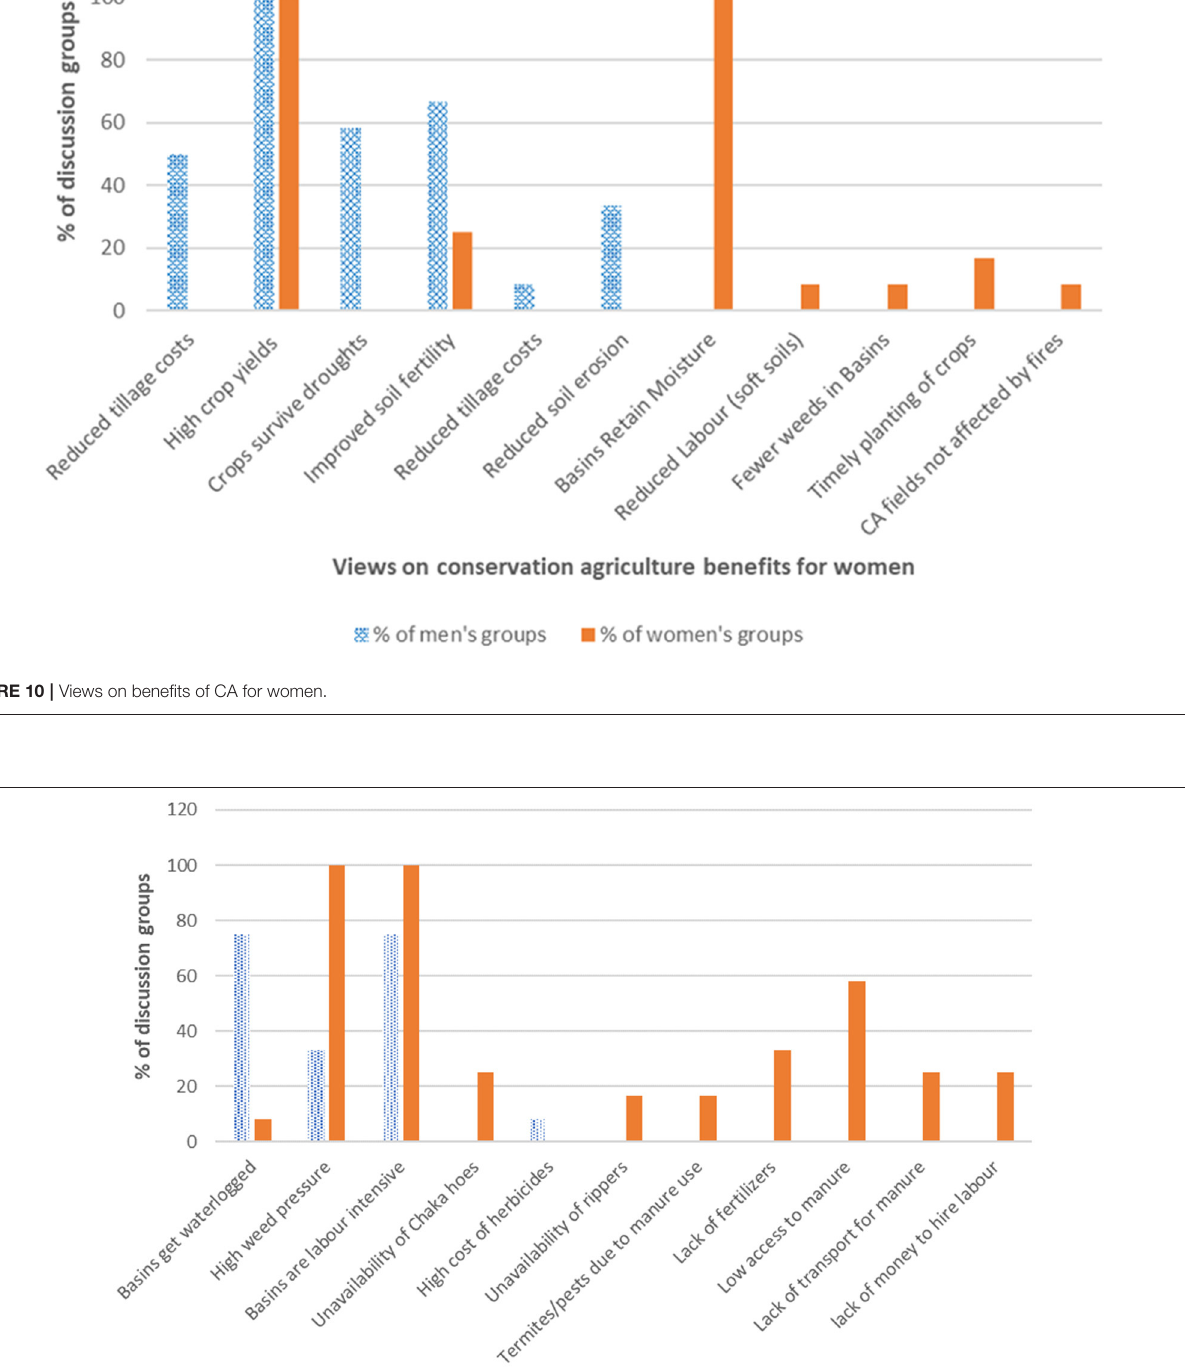
Frontiers in Sustainable Food Systems |